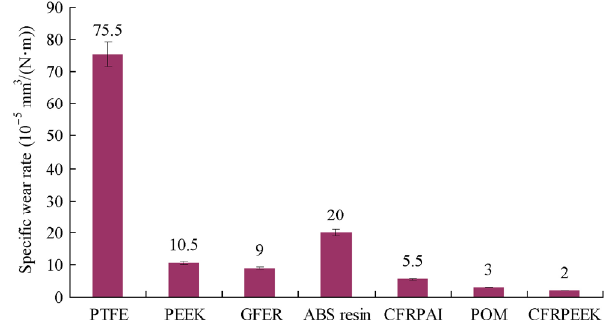
Fig. 4 The specific wear rates of the polymer